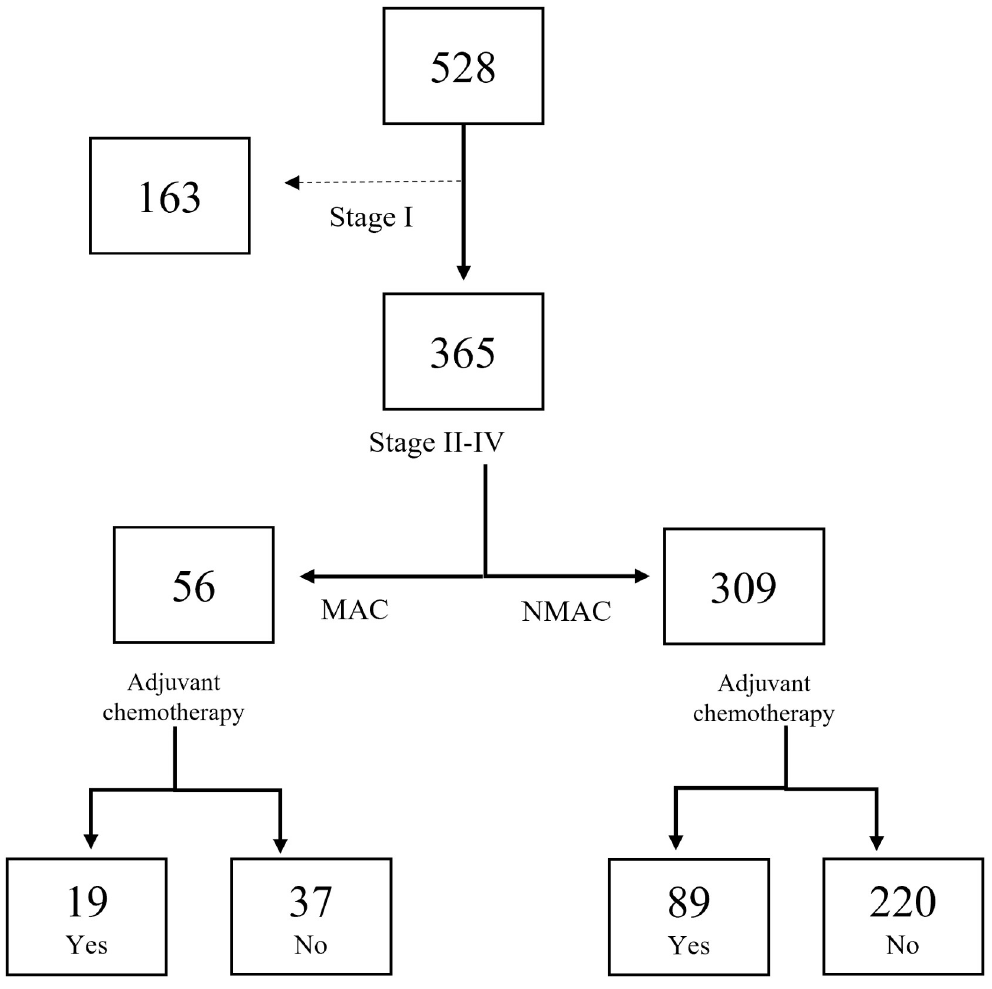
Fig 1. Flow-chart of rectal cancer patients in the